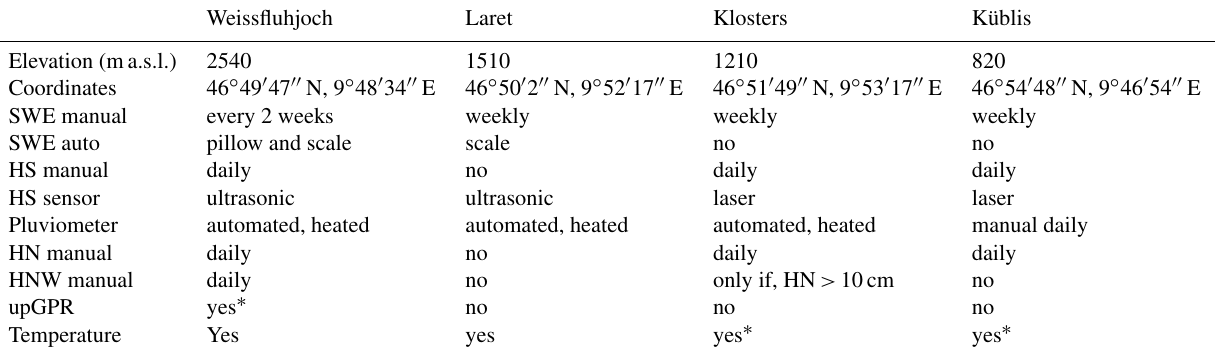
Table 1. Summary of the station characteristics. An asterisk ∗ indicates that the measurements were only available during the second 2019– 2020 winter season; for the 2018–2019 winter season we used data from nearby stations. HN stands for height of new snow and HNW for water equivalent of snowfall.